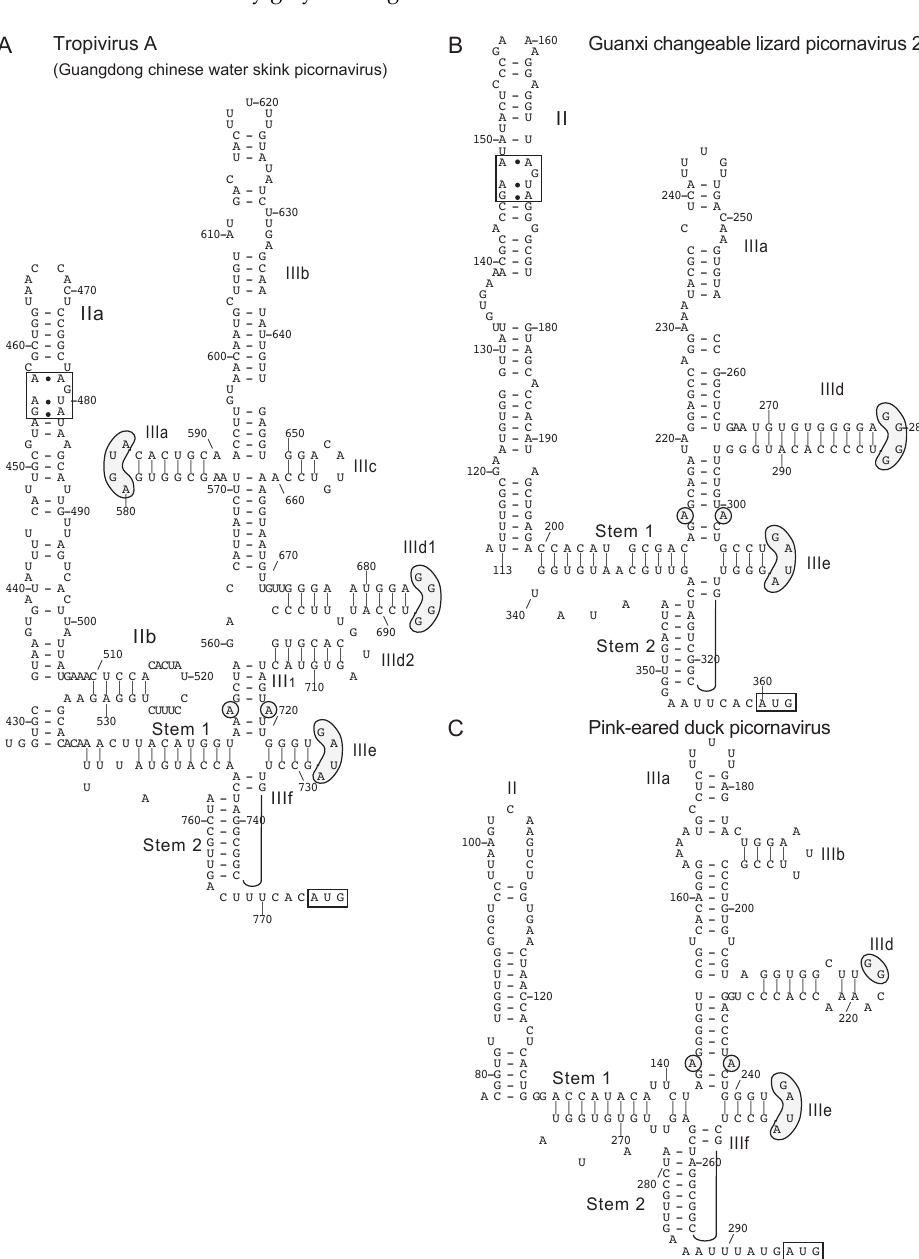
Figure 4. Structurally diverse type IV IRESs in novel picornavirus genomes. ( A ) Model of the Tropivirus A (Guangdong Chinese water skink picornavirus) IRES (GenBank: MG600091) [141], ( B ) Model